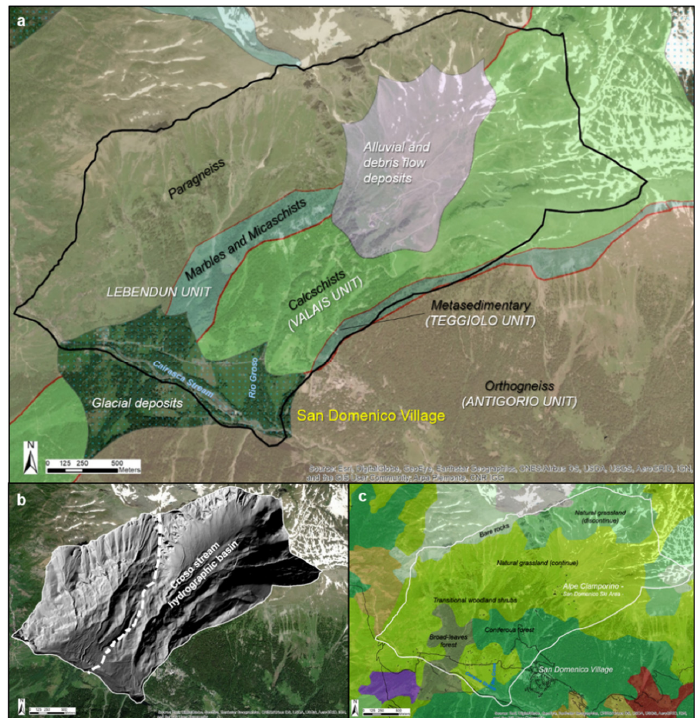
Figure 2. The investigated slope nearby the San Domenico hamlet and the Alpe Ciamporino ski